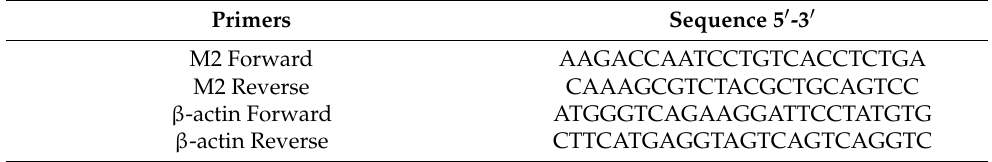
Table 1. Oligonucleotide sequence of the primers.